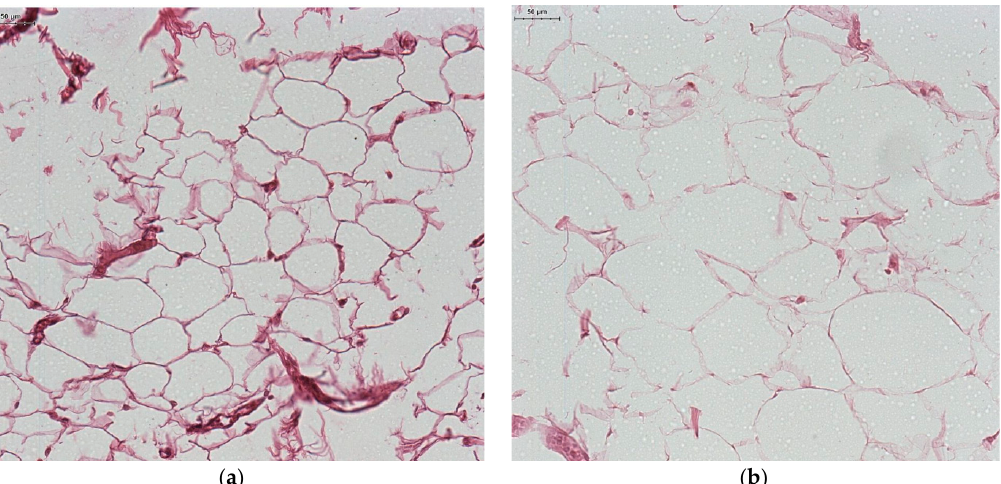
Figure 2. Adipose tissue: a control group (( a ) non-obese patient); ( b ) Obese patient (H&E staining).